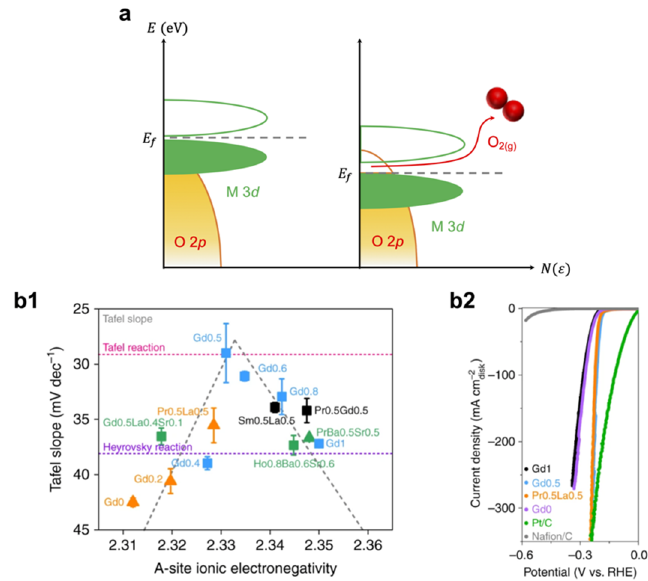
Figure 5. ( a ) Activating the lattice oxygen redox by improving the metal-oxygen hybridization: ( a ) A schematic illustration of the band structures observed for LaCoO 3 and SrCoO 3 during the OER. ( b ) A-site ionic electronegativity as a descriptor of perovskite oxide HER activity: ( b1 ) The HER Tafel slope as a function of the A-site ionic electronegativity and ( b2 ) polarization curve; reproduced with permission [79] Copyright (2019), Springer Nature.